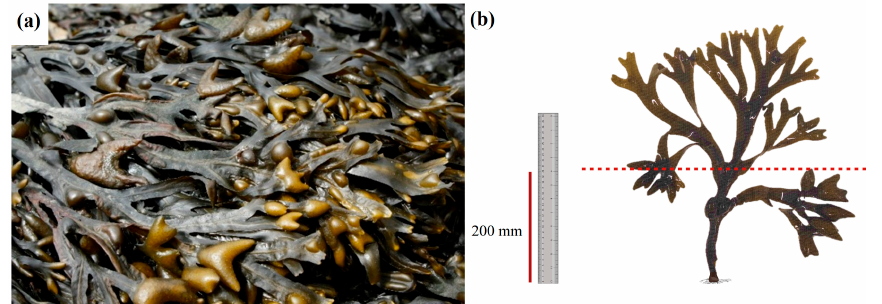
Figure 2. ( a ) The macroalga Fucus vesiculosus from Ria de Aveiro; ( b ) sample collection cut 200 mm above the fi xation point. above the fixation